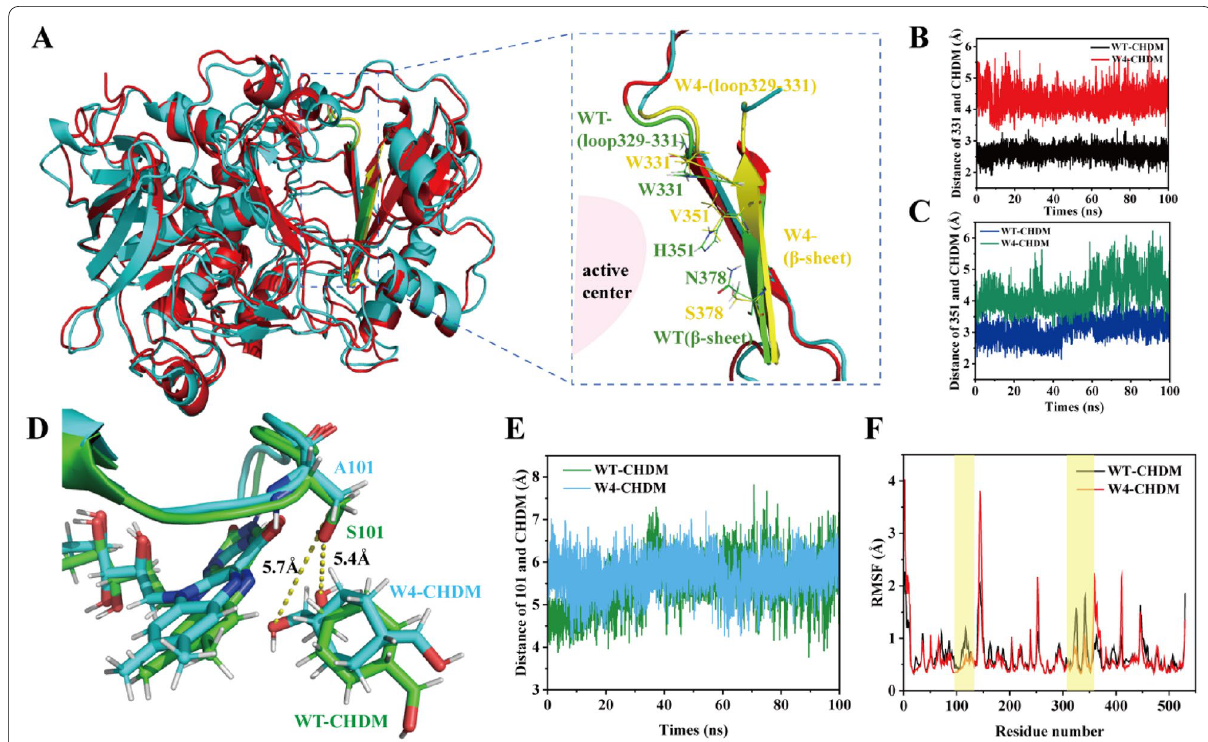
Fig. 5 Structure alignments of WT and variant W4. A Structure alignments of WT-CHDM and variant W4-CHDM in loop 329–332 and β-sheet. WT-CHDM is shown in green, variant W4-CHDM is shown in yellow. B Panel shows the distance of W331 and CHDM in both the WT and variant W4. C Panel shows the distance of residue 351 and CHDM in both the WT and variant W4. D Structure alignments of WT-CHDM and variant W4-CHDM in loop 100–103, WT-CHDM is shown in green, variant W4-CHDM is shown in blue. E Panel shows the distance of residue 101 and CHDM in both the WT and variant W4. F Panel shows the RMSF values for WT-CHDM and variant W4-CHDM